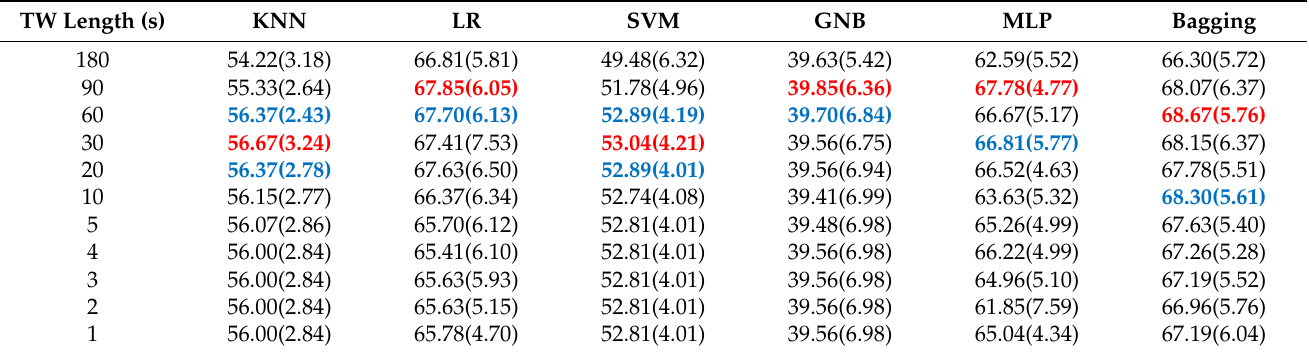
Table 5. The recognition results (mean accuracy and standard deviation) of PSD features extracted from separate frequency bands when using different classifiers under different TW lengths without ELBN. The highest and second-highest accuracies of each classifier are highlighted in bold red and bold blue, respectively.